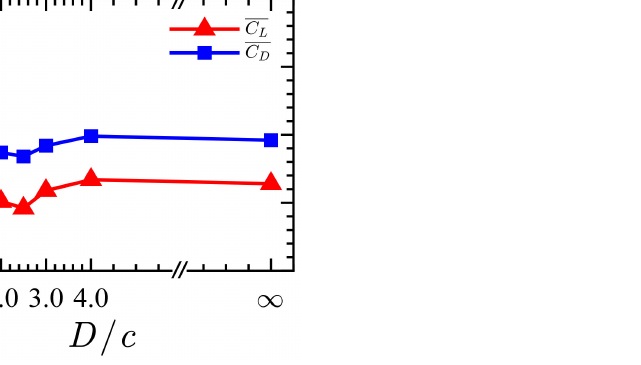
Figure 18. Cycled-averaged lift ( C L ) and drag ( C D ) coefficients versus wall clearance ( D / c ) at Re = 100.